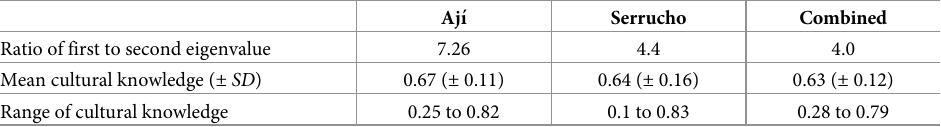
Table 4. Cultural consensus in the first factor (‘market lifestyle’) in Aji, Serrucho and